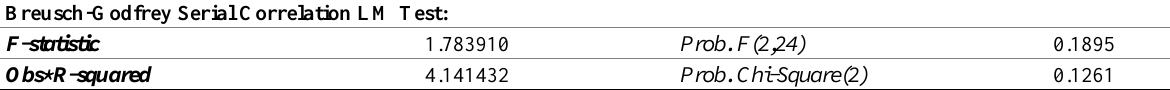
Table 5: Test Results of Breusch-Godfrey Serial Correlation LM Test